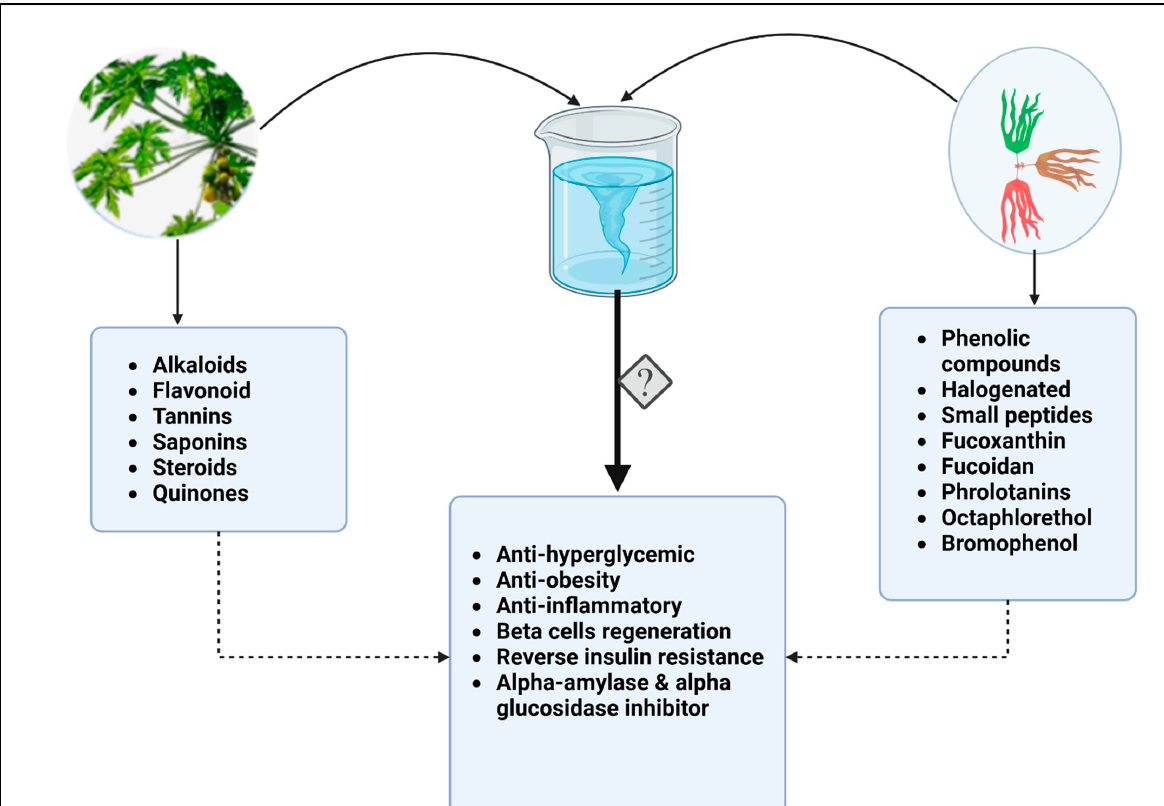
Figure 2. Combined bioactive compounds from papaya and seaweed may have higher potency against diabetes. While papaya leaves, fruit and roots contain alkaloids, flavonoids, tannins, saponins, steroids, and quinones, some of the active compounds in brown, red, and green seaweeds include phenolic and halogenated compounds. Phlorotannins, fucoxanthins, and octaphlorethol, small peptides, are also antidiabetic, anti-obesity, and anti-inflammatory, as well as acting as beta cells regenerators and inhibiting glucose metabolic enzymes. A combination of bioactive compounds during extraction, or in their crude form may have synergistic effect and increase therapeutic potential of these natural products.